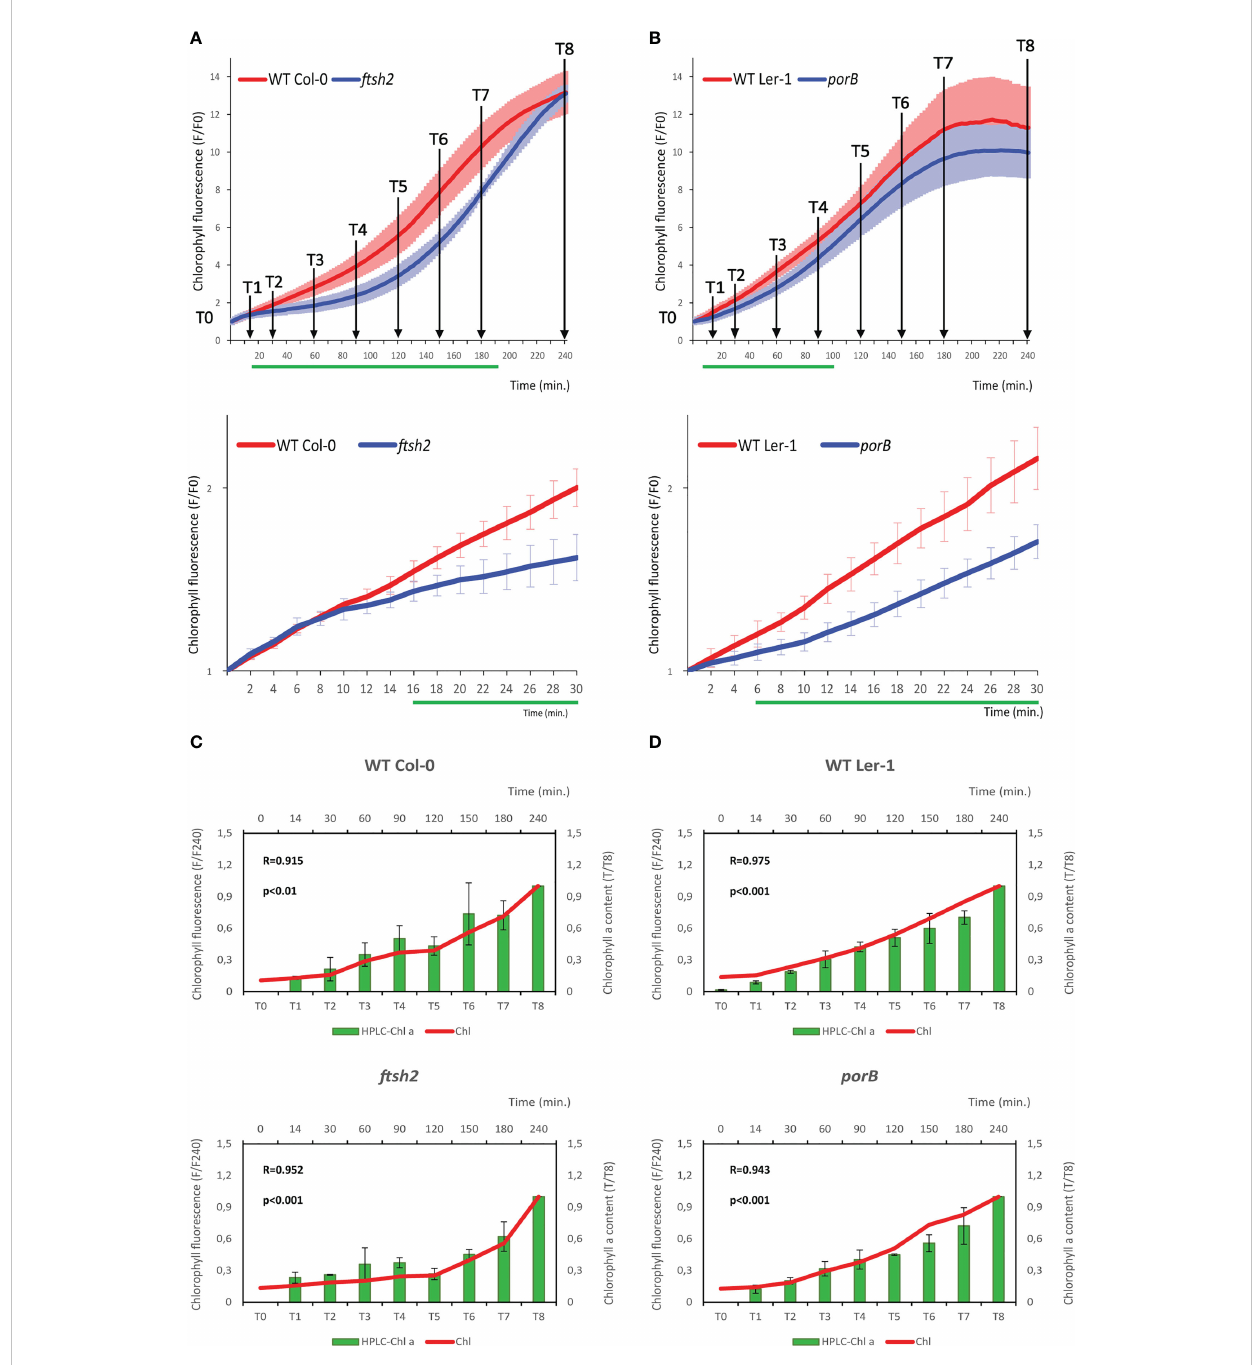
FIGURE 3 iReenCAM results tightly correlate with HPLC-measured chlorophyll a kinetics in both WT and chlorophyll biosynthesis-de fi cient mutants. (A, B) Chlorophyll accumulation in 4-days-old etiolated WT Col-0 and ftsh2 mutant line (A) and WT Ler-1 and porB seedlings (B) . Data represent the mean values ± SD, n=9 of raw data ( fl uorescence F) normalized to the mean fl uorescence value at T0 (F0). The green lines under the x axis depict time intervals with signi fi cantly different values between WT and the mutant (P<0.05). The time points (T0 to T8) used for seedlings collection and HPLC analysis (C, D) are designated in the charts. (C, D) Results of HPLC analysis of chlorophyll content in T0-T8 in WT Col-0 and ftsh2 mutant (C) and WT Ler-1 and porB mutant (D) seedlings. Data are the mean ± SD, n=9 of raw data (mg/g of fresh weight normalized to T8). Chlorophyll fl uorescence measured by iReenCAM (normalized to T240) positively correlates with chlorophyll a content measured by HPLC analysis for both WT and mutant backgrounds used; R-value represents Pearson ’ s correlation coef fi